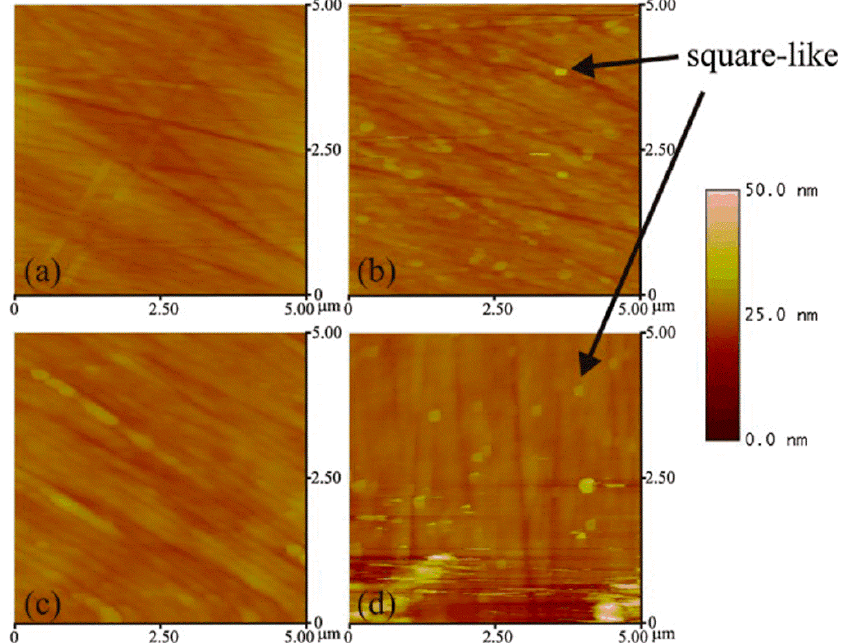
Figure 8. AFM images of DSS 2205 sample: ( a ) in artificial saliva (AS) after being exposed to the potential of 0.8 V for 45 min, ( b ) in AS after additional exposure to the potential of 1 V for 11.6 min, ( c ) in physiological solution (PS) after being exposed to a potential of 0.8 V for 17.2 min, and ( d ) in PS after additional exposure to 1 V for 7.5 min. Adapted with permission from Reference [45]; copyright 2011 Elsevier Ltd.